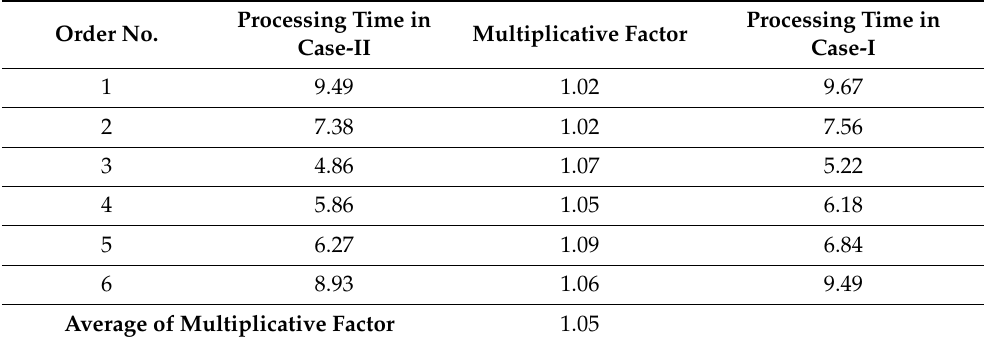
Table 9. Comparison of the processing times of Case-I and Case-II. Order No.